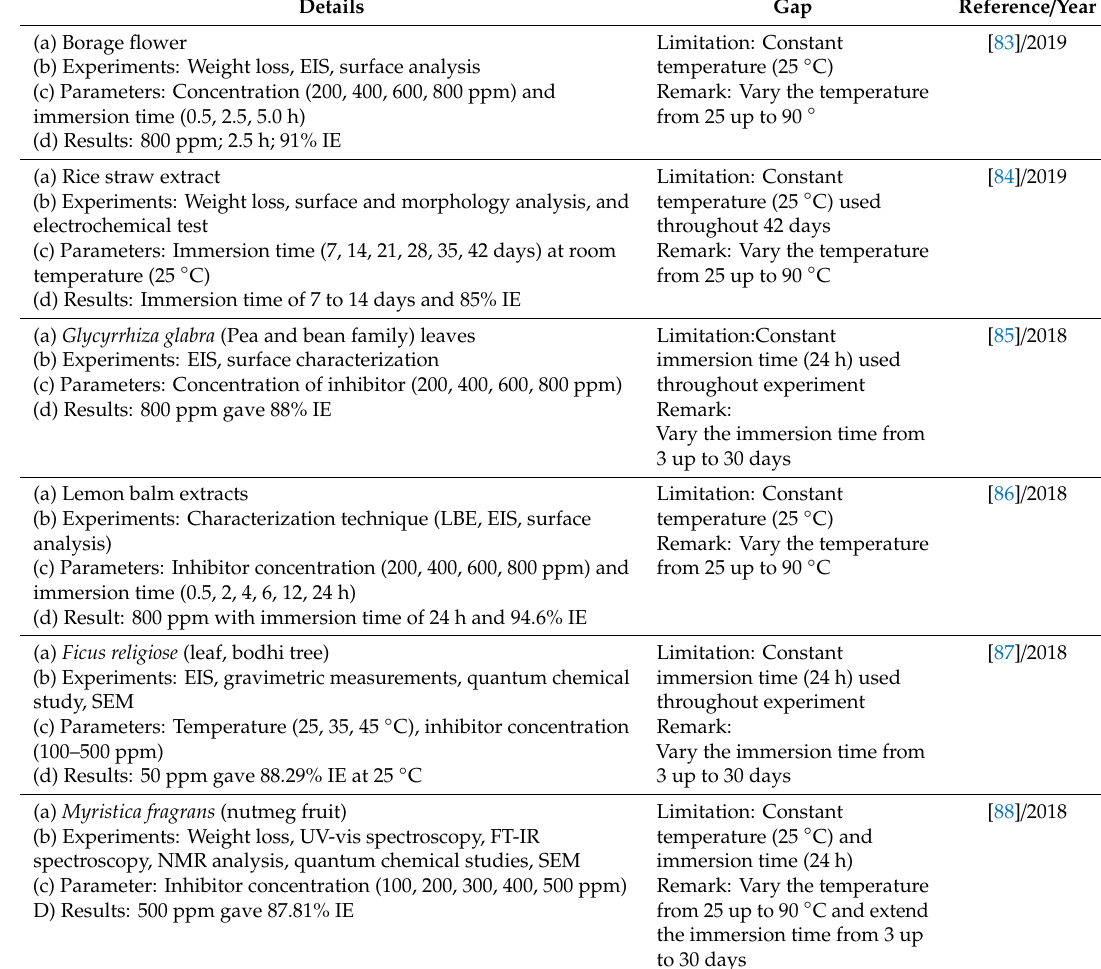
Table 1. Summary of research gaps for plant-based green corrosion inhibitors from 2010 to 2019. -Note: EIS-Electrochemical impedance spectroscopy; IE- inhibition e ffi ciency; FTIR- fourier transformed infrared spectroscopy